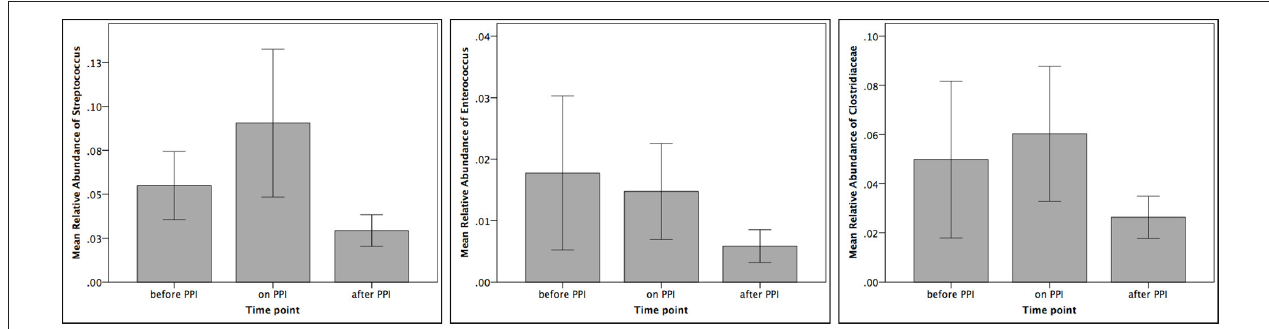
FIGURE 3 | Relative abundances of Streptococcus, Enterococcus and Clostridiaceae at the three different time points tested ( n = 12 per time point).